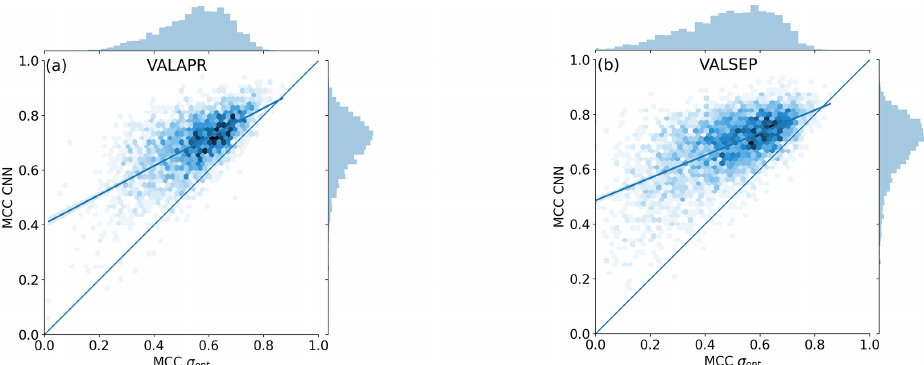
Figure 8. Scatter density plots of the MCC achieved by the CNN and σ opt on data from individual CMLs. Both methods are MCC optimized for the unbalanced data from VALAPR; while the CNN keeps the optimized performance in September, the performance of σ opt